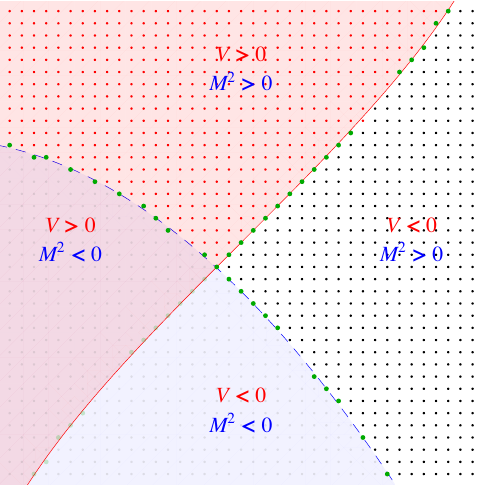
Figure 1 . Each dot is a minimum in the Z 2 -symmetric limit. For illustrative purposes we replace 2 N points in N dimensions by points in 2 dimensions. Adding Z 2 -breaking terms some minima disappear or appear; a light scalar is present around the boundary (blue curve); the identity of the light scalar (and thereby its Yukawa couplings) varies in the landscape. Another boundary (in red) separates minima according to the sign of their vacuum energy; a small cosmological constant is present around the